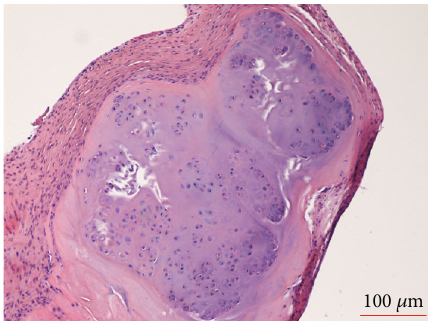
Figure 2: Histopathology. The resected specimen was an unorientable fragment of about 5mm of diameter. It was routinely formalin fi xed and para ffi n embedded for the histological study. Microscopic examination revealed that the lesion consisted of three components: fi broblastic spindle cells, cartilage without signi fi cant cellular atypia, and small marginal irregular bony trabeculae. These features were diagnostic of chondroma.